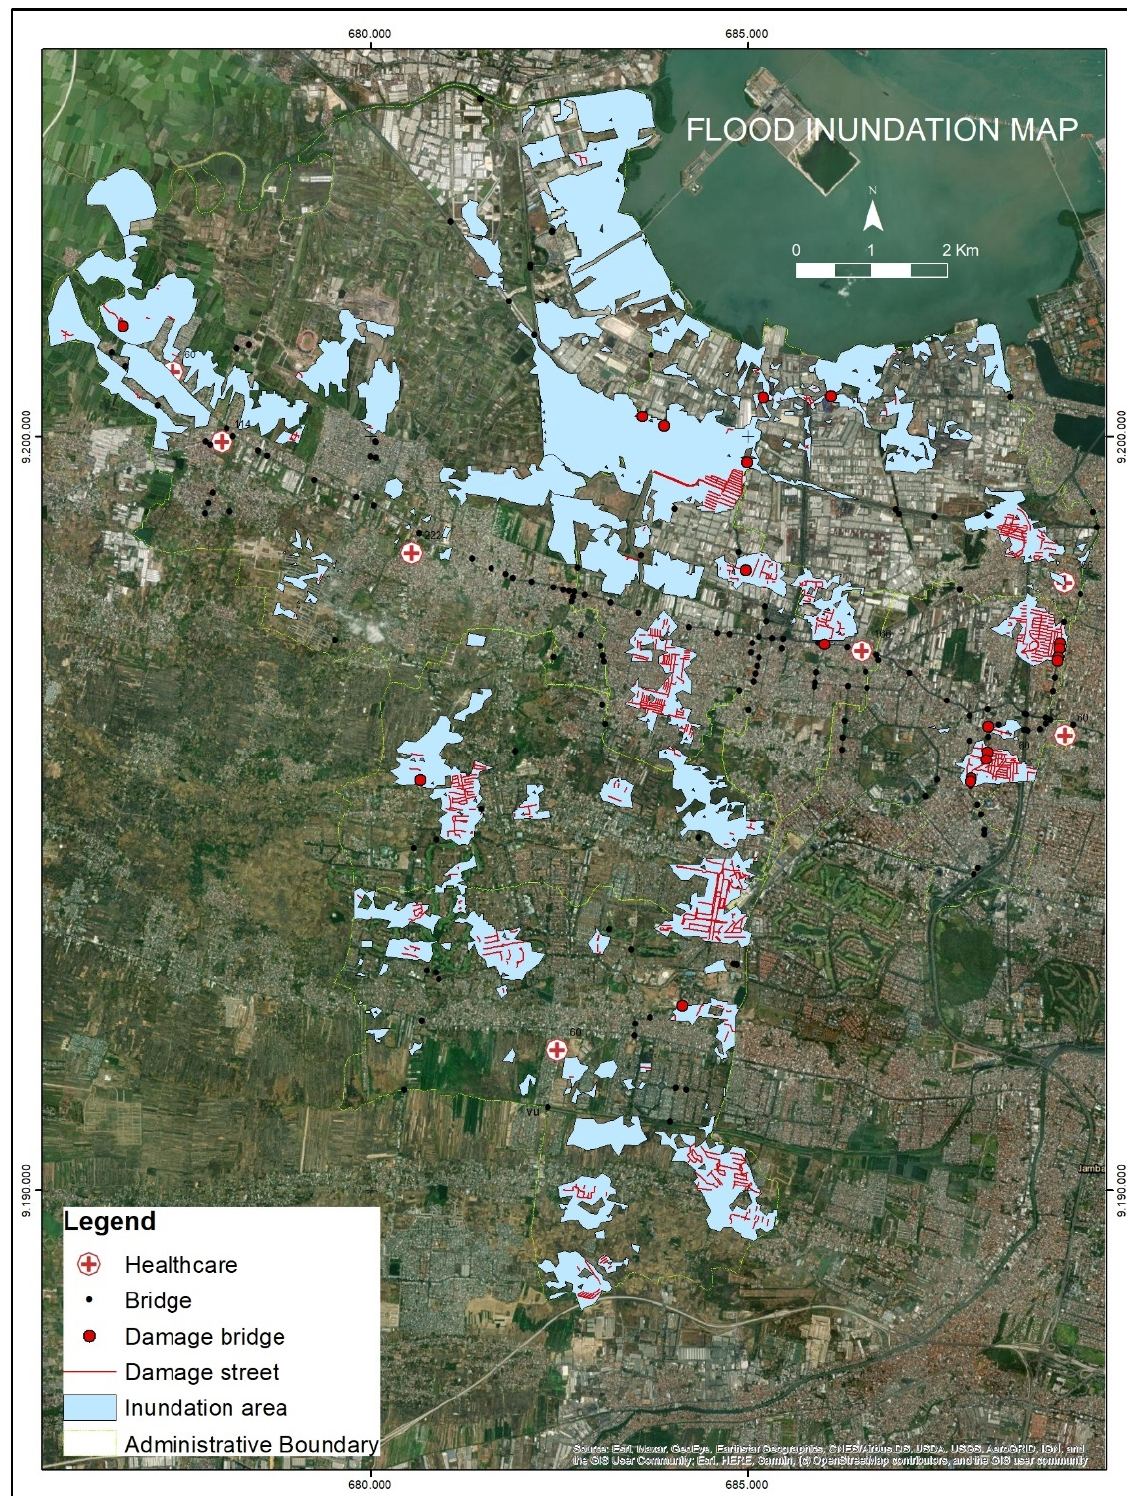
Figure 6. Area of potential inundation impact.